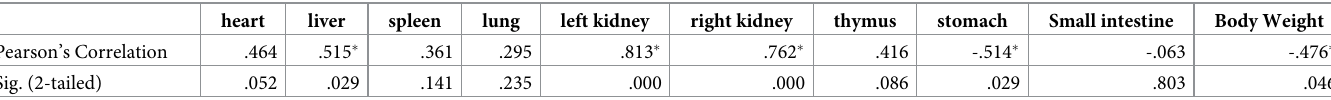
Table 2. Correlation between SUA and organ indexes in rats weighing 180–220 g (n = 18). heart liver spleen lung left kidney right kidney thymus stomach Small intestine Body Weight Pearson’s Correlation .464 .515 � .361 .295 .813 � .762 � .416 -.514 � -.063 -.476 � .052 .029 .141 .235 .000 .000 .086 .029 .803 .046